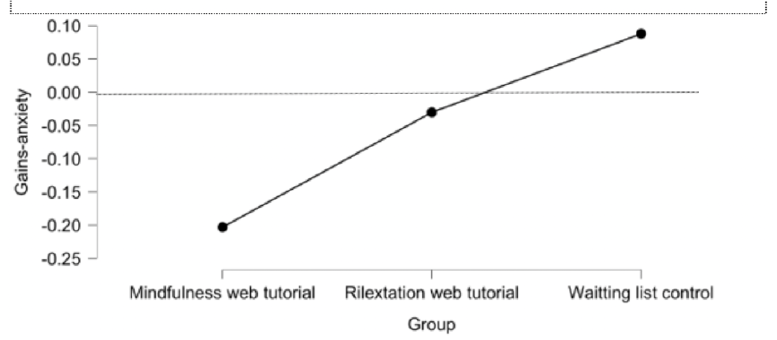
Figure 3. Gains Score Anxiety Among Groups (Figure with permission ©Suranata, et.,all